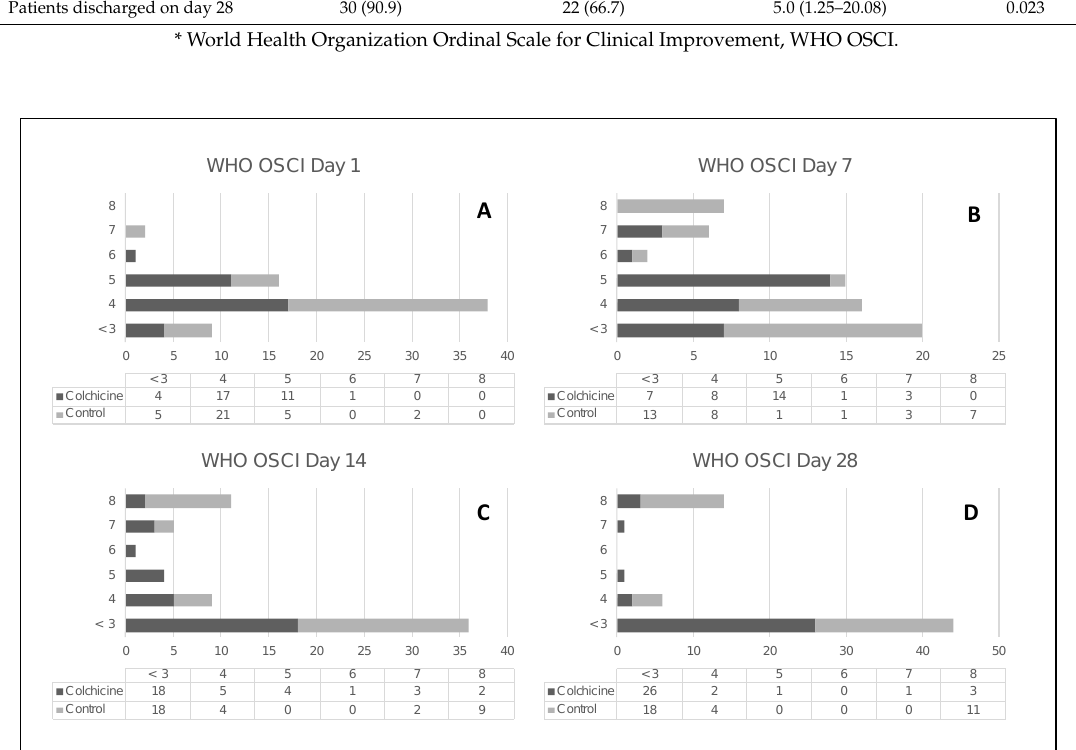
Table 2. Comparison of endpoints between groups. Colchicine ( n = 33) ( n , %)